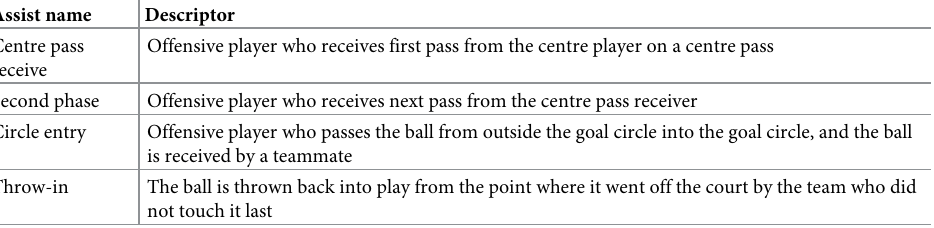
Table 1. List of definitions for events that are automatically recorded by the NetballStats